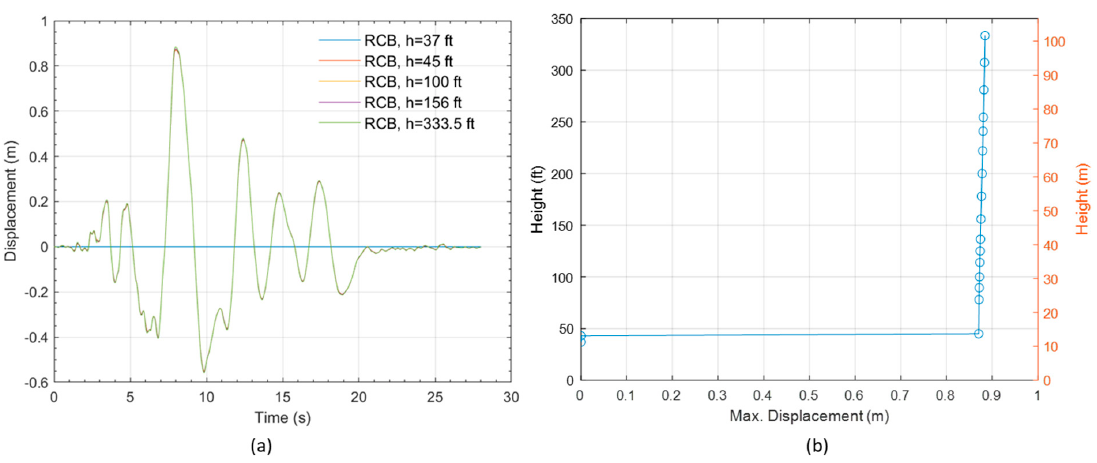
Figure 8. Displacement response of nuclear power plant (NPP): ( a ) time histories and ( b ) maximum displacement for the ground motion in Figure 7.